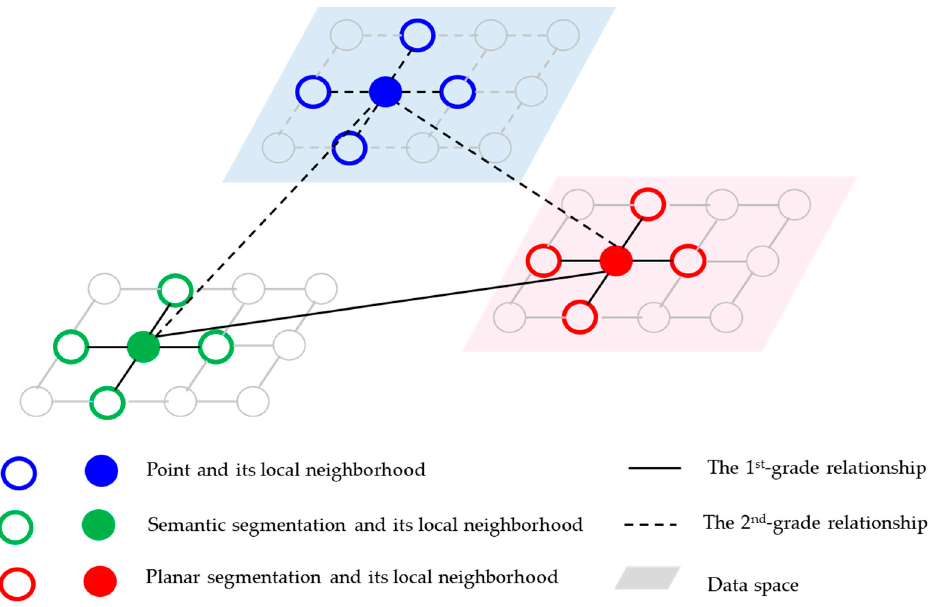
Figure 4. Relationship definition of multi-primitives in the proposed method. Table 2. Pairwise features